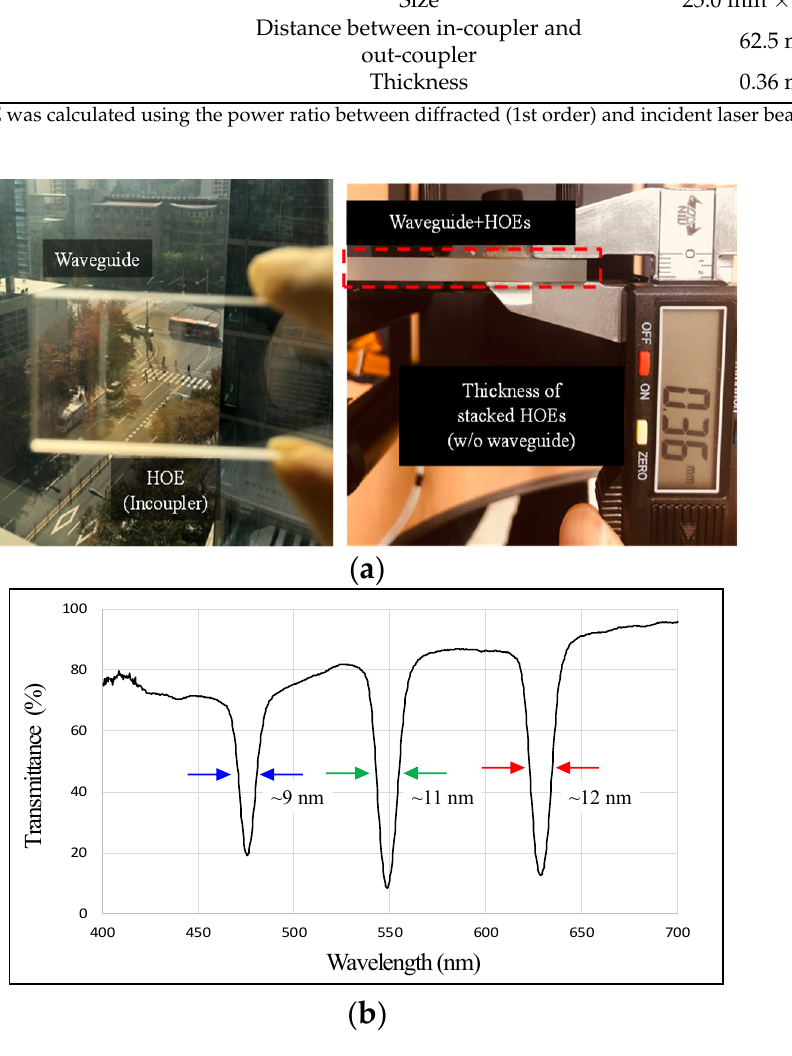
Figure 7. Characteristics of fabricated HOE couplers: ( a ) the fabricated waveguide sample with three layers of photopolymers, and ( b ) the transmittance spectrum of fabricated HOE coupler, when the probe wave was normally incident on the photopolymer.